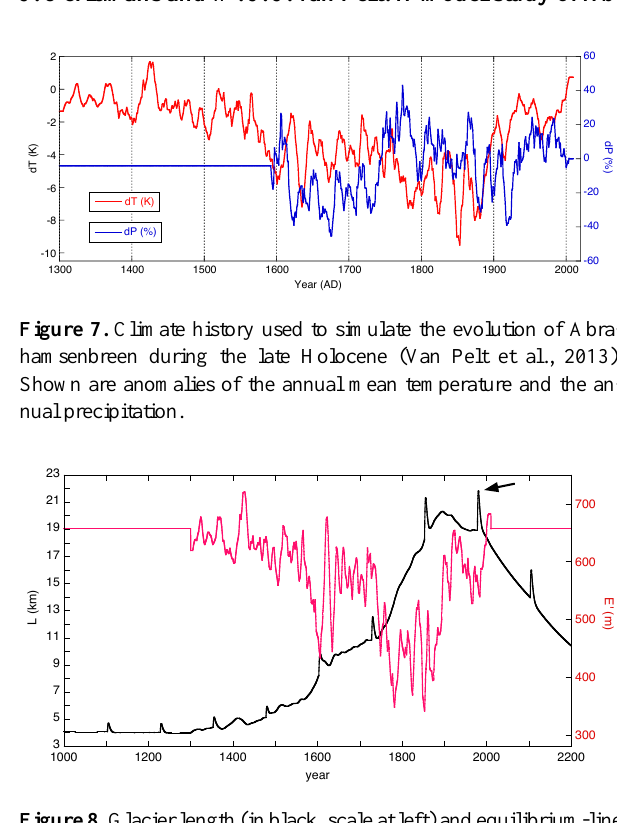
Figure 8. Glacier length (in black, scale at left) and equilibrium-line Fig. 8. Glacier length (in black, scale at left) and equilibrium-line altitude (in red, scale at 2 altitude (in red, scale at right) from the simulation of Abrahamsen- right) from the simulation of Abrahamsenbreen. The arrow indicates the 1978 surge of the 3 breen. The arrow indicates the 1978 surge of the glacier. glacier. 4